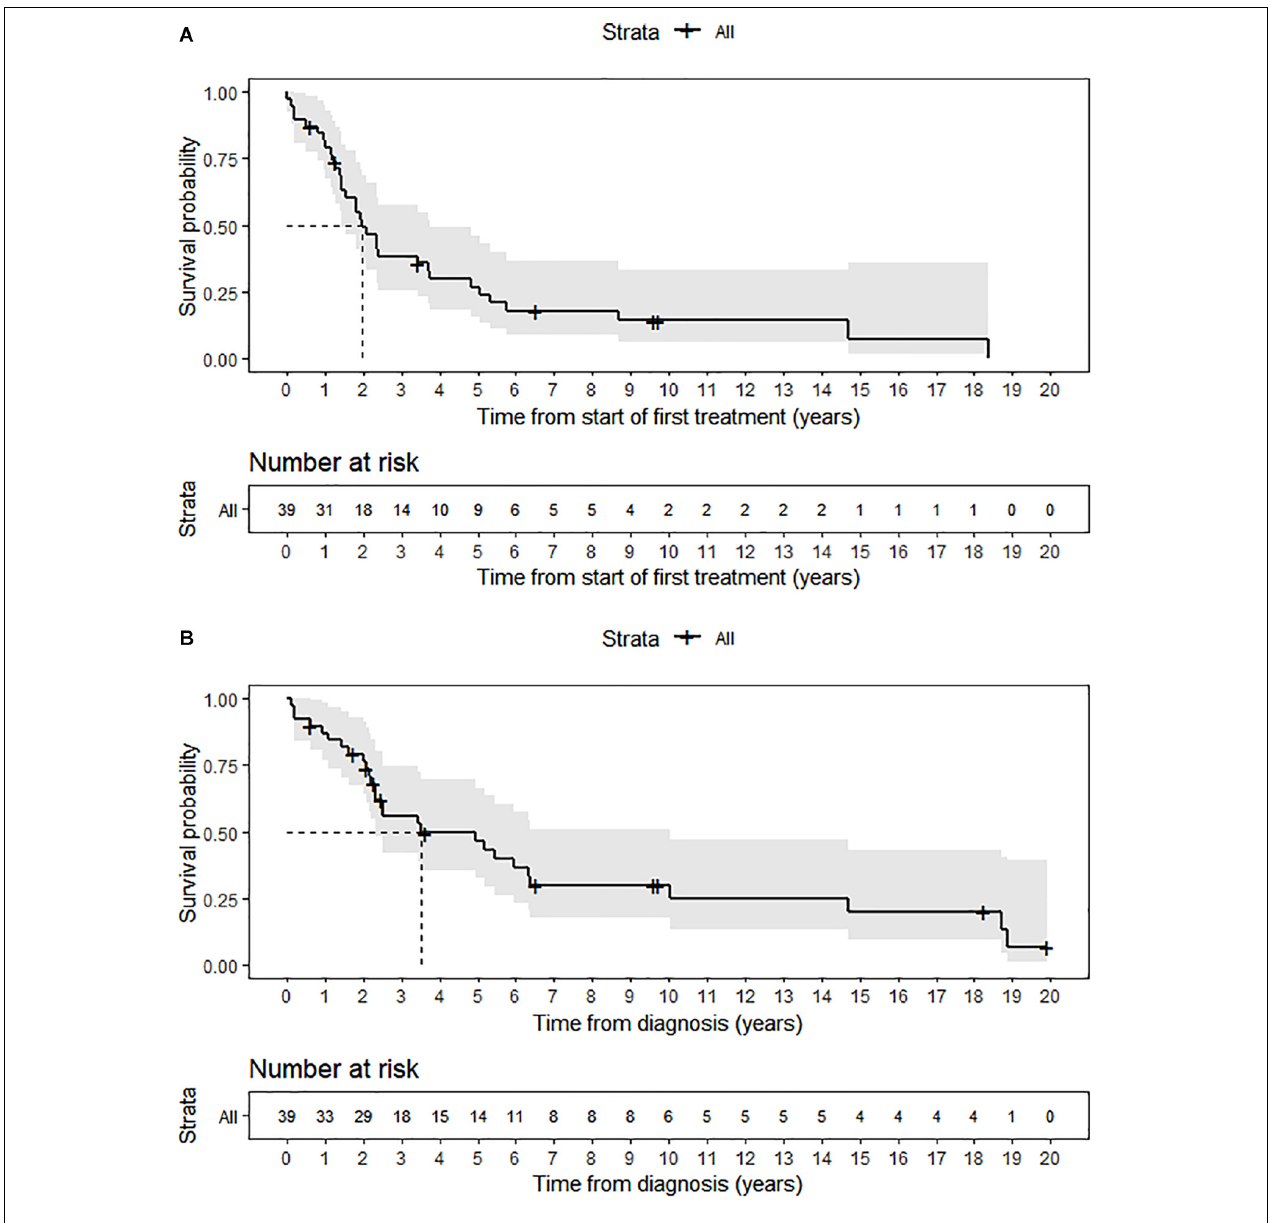
FIGURE 1 | (A) Progression-free survival. (B)